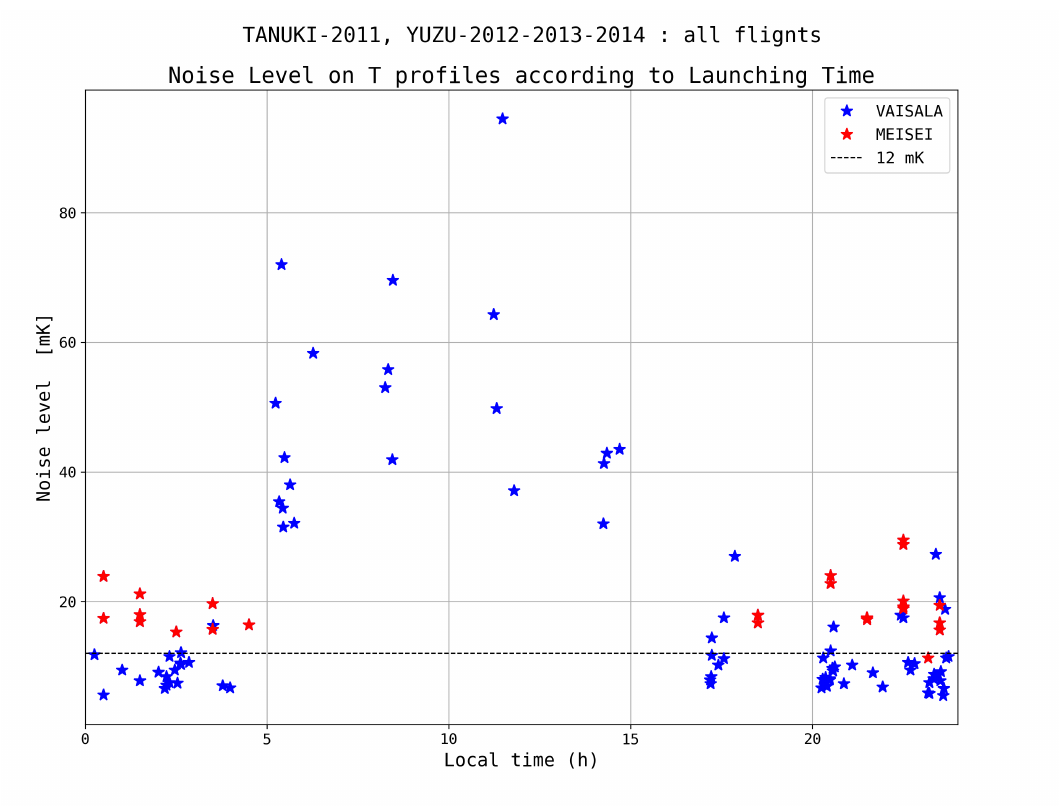
Figure 2. Noise levels on the raw temperature profiles for the 111 flights of the 4 campaigns versus launching time. The blue symbols correspond to the VAISALA sondes, the red ones to the MEISEI sondes. The horizontal dashed line shows the 12 mK noise level (chosen somewhat arbitrarily as a typical low-noise reference). It is very clear that daytime profiles are much more noisy than night-time